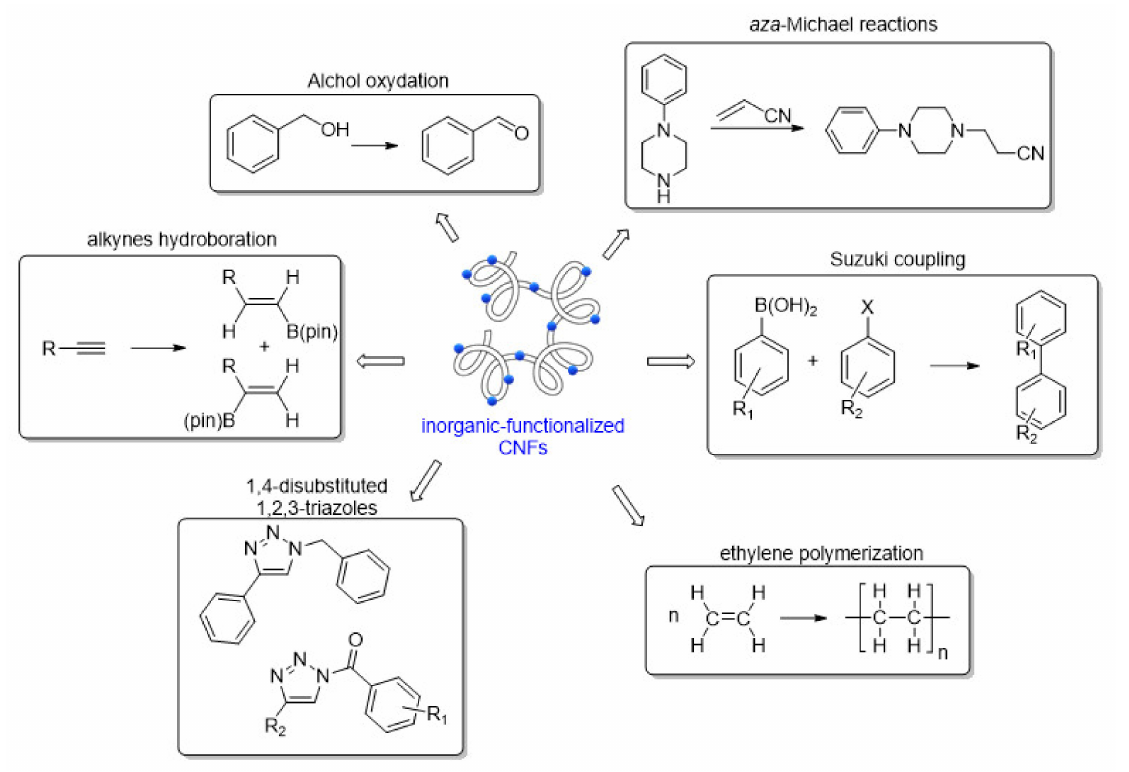
Figure 6. Catalytic applications of inorganic functionalized